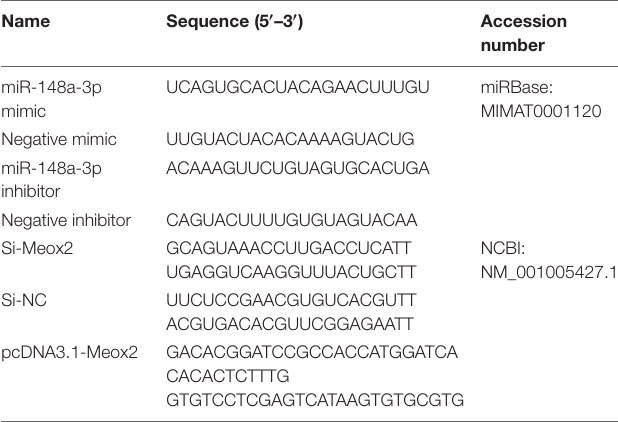
TABLE 1 | RNA oligonucleotide and plasmid construction in this article.